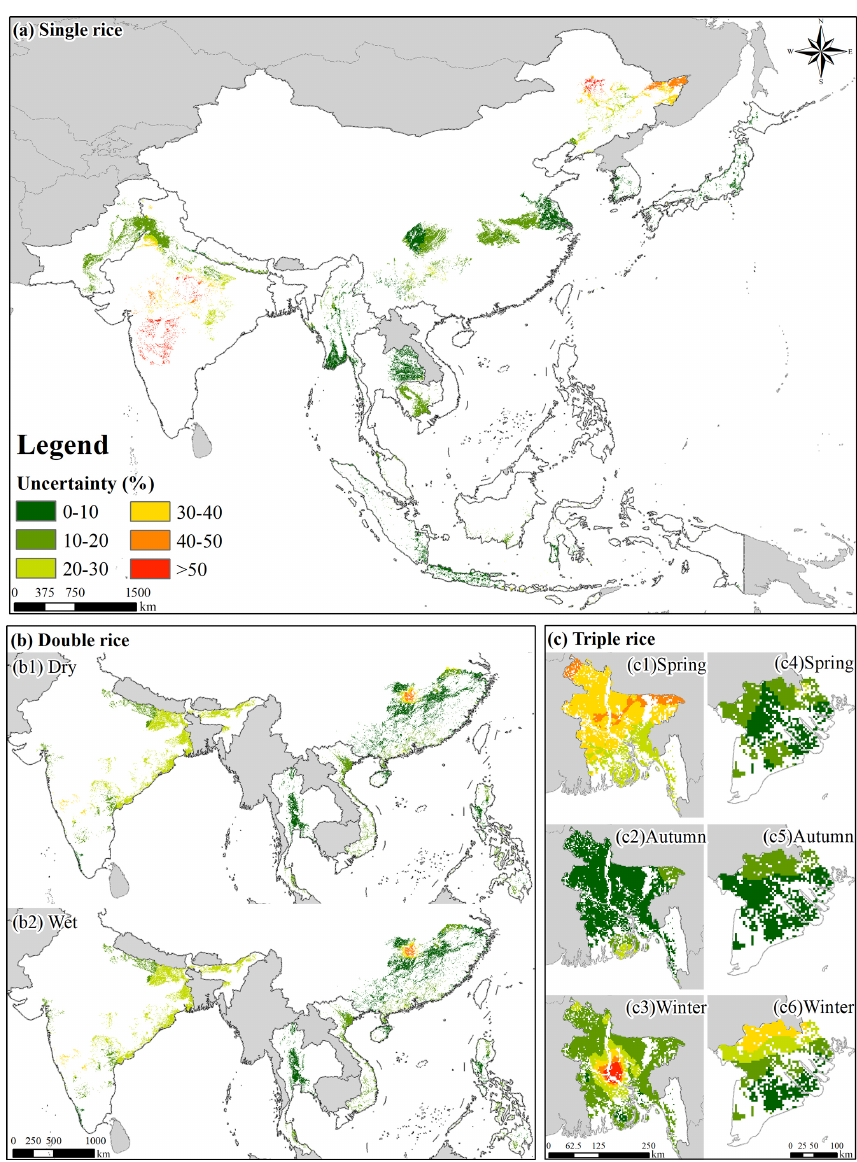
Figure 10. The spatial distribution of uncertainty (RRMSE, %) in